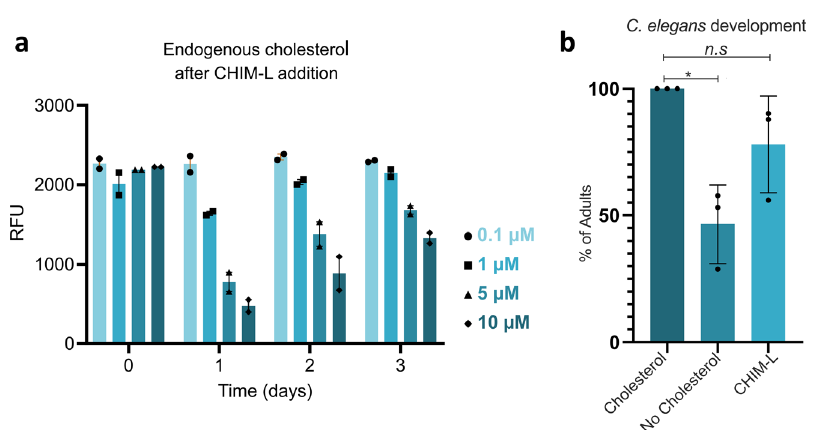
Fig 5 CHIM-L can functionally replace membrane cholesterol. a Relative levels of endogenous cholesterol in HUVEC treated with various concentrations of CHIM-L (0.1, 1, 5, and 10 µ M) for 1.5 h at 37 °C. Following treatment, cells were washed three times in CHIM-free medium and analyzed directly or incubated up to 3 days in normal medium. Cholesterol concentration was quanti fi ed using a fl uorometric assay (Amplex) and is given in relative fl uorescence units (RFU). Error bars + SEM. b Effect of cholesterol removal and CHIM-L replacement diet on C. elegans development. Worms were investigated for two generations under standard cholesterol conditions (5 mg/l), no-added cholesterol, or CHIM-L (5 mg/l), and the number of worms that reached adulthood was quanti fi ed for the different feeding schemes (91 worms for cholesterol, 137 for no-added cholesterol, and 143 animals for CHIM-L). Error bars are SD. * p <